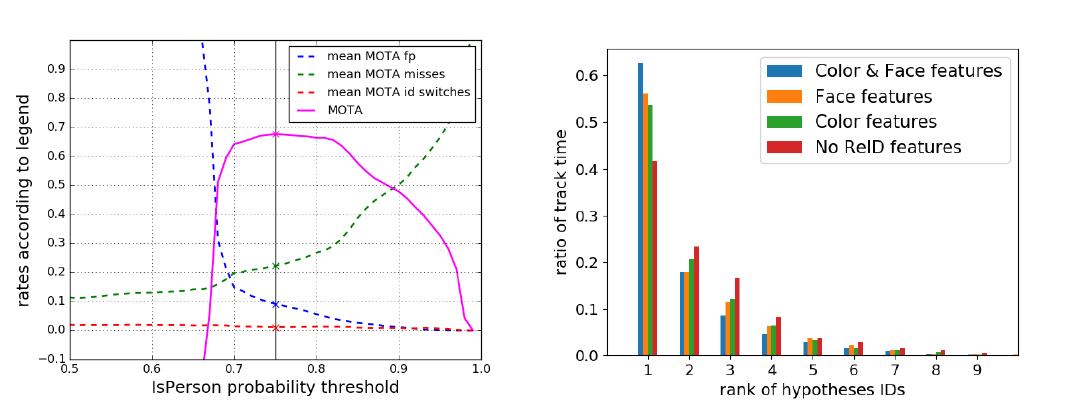
Figure 6. Left : Evolution of MOTA values with different existence thresholds. While higher thresholds lower the amount of false positives and ID switches, the amount of missed hypotheses increases. The threshold with the highest MOTA determines the best working point for our tracker in the application phase (vertical black line). Right : Sorted histograms for hypothesis IDs assigned to ground truth IDs. Colors indicate different combinations of features used. It can be seen, that by using more complex features, the values in the first bin almost doubles compared to a tracker without re-identification features. This first bin reflects the proportion of time a person has the correct ID, even if s/he has left the field of view in between. This is important for a robust re-identification of the target user in our gait training